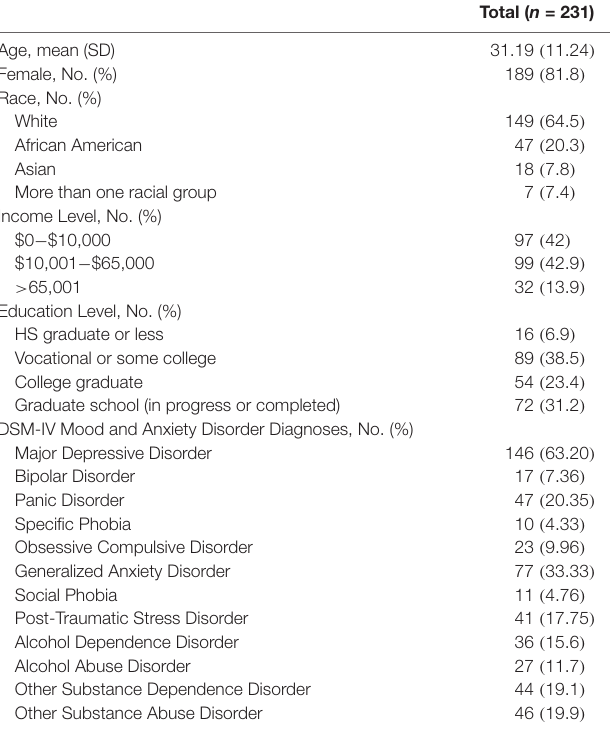
TABLE 1 | Participant